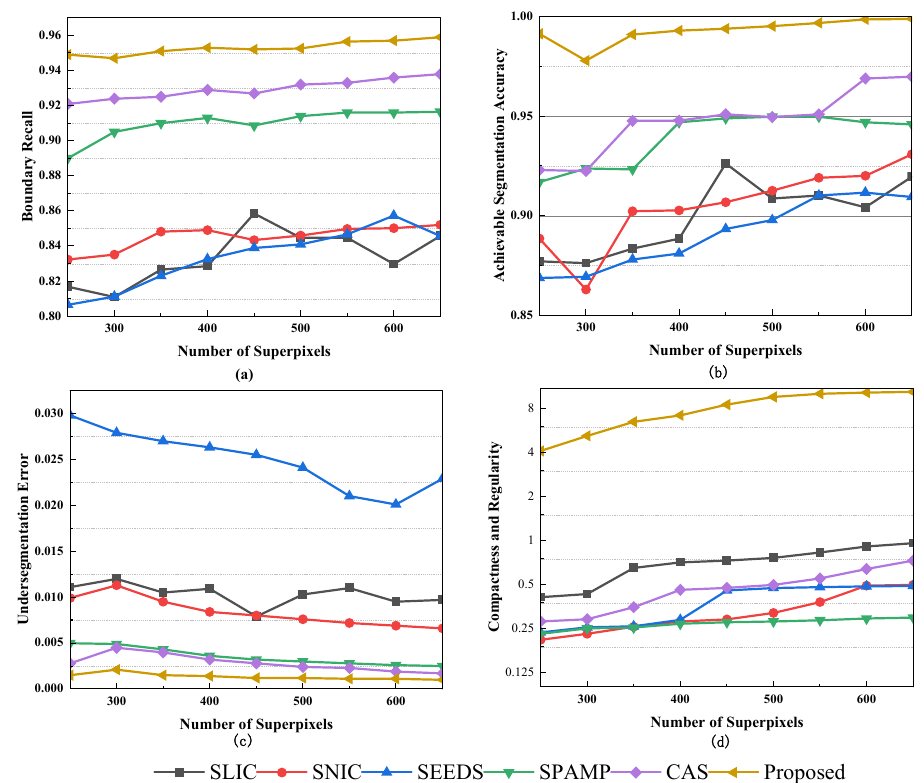
Figure 14. Superpixel generation results for the image SI 1 . ( a ) SLIC, ( b ) SNIC, ( c ) SEEDS, ( d ) SPAMP, ( e ) CAS, and ( f ) EDTRS.